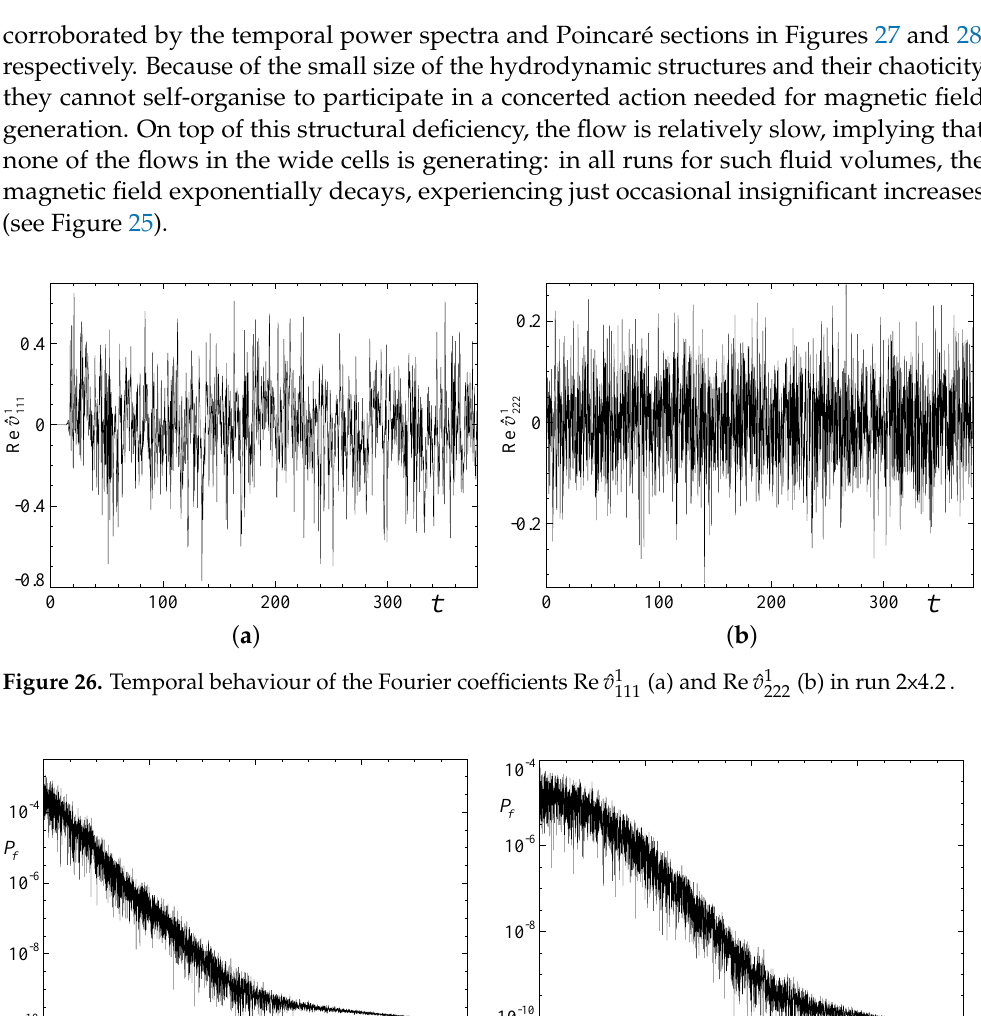
Figure 27. Temporal power spectra of the Fourier coefficients Re ˆ v 1 interval 40 ≤ t ≤ 381.21 in run 2 x 4.2.